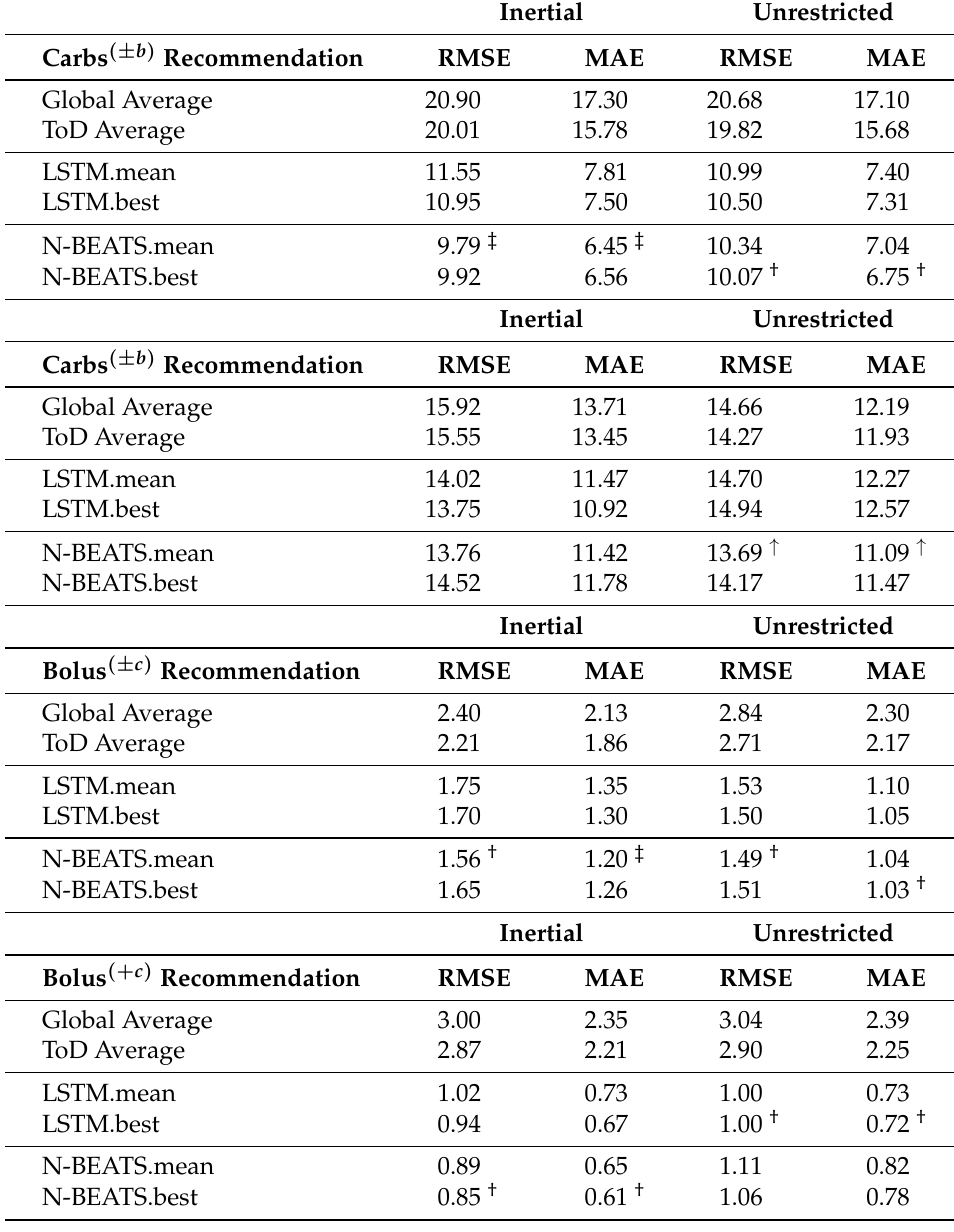
Table 11. Results for each recommendation scenario, for both classes of examples. The simple † indicates a p -value < 0.05 when using a one-tailed t -test to compare against the baseline results; the double ‡ indicates statistical significance for comparison against the baselines as well as against the competing neural method; the ↑ indicates significant with respect to the Global Average baseline